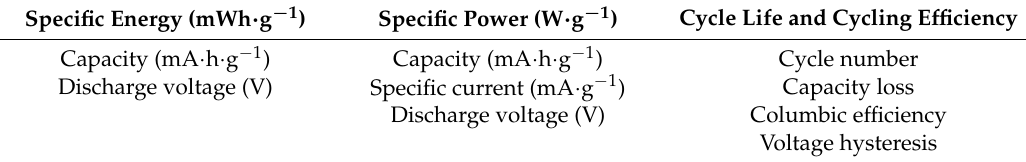
Table A2. Criteria used to determine performance of the electrode